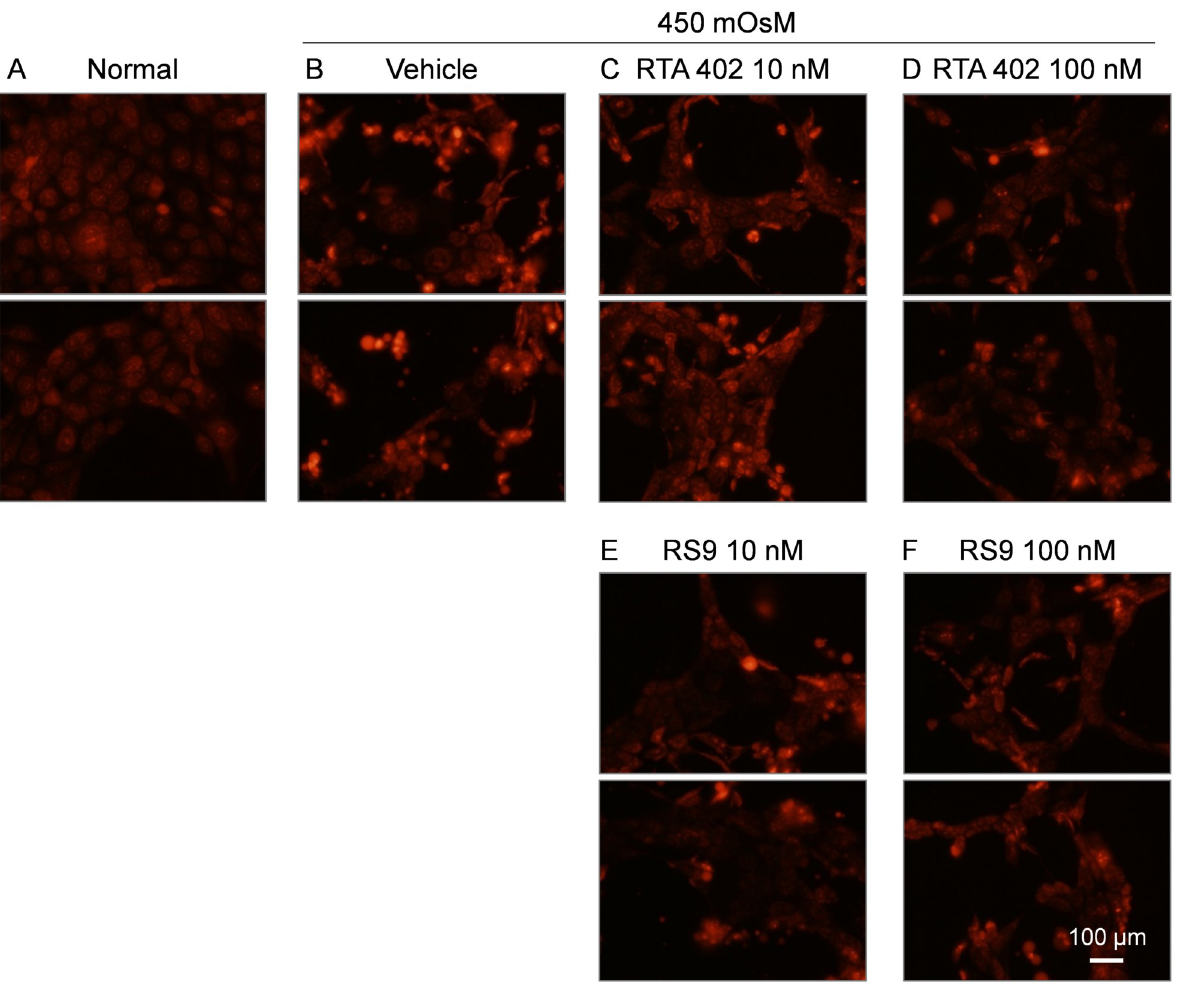
Fig 3. Inhibitory effects of RTA402 and RS9 on ROS production in HCE-T cells exposed to 450 mOsM of hyperosmotic medium. After 24 hours of RTA 402 or RS9 pretreatment, cells were exposed to 450 mOsM of hyperosmotic medium. Osmolarity was modified by addition of NaCl. ROS levels were detected by dihydroethidium (DHE) staining and analyzed by fluorescence microscopy 4 hours after the induction of hyperosmotic stress. Red color indicated oxidation form of DHE. A, Staining of cells under isosmotic culture conditions and B-F, staining under hyperosmotic culture conditions. ROS production was increased in cells exposed to hyperosmotic medium B, while ROS production was suppressed in RTA 402 or RS9 pretreated cells (C-F). Experiments were conducted in duplicate and repeated twice. Five images were obtained from one culture and representative images are